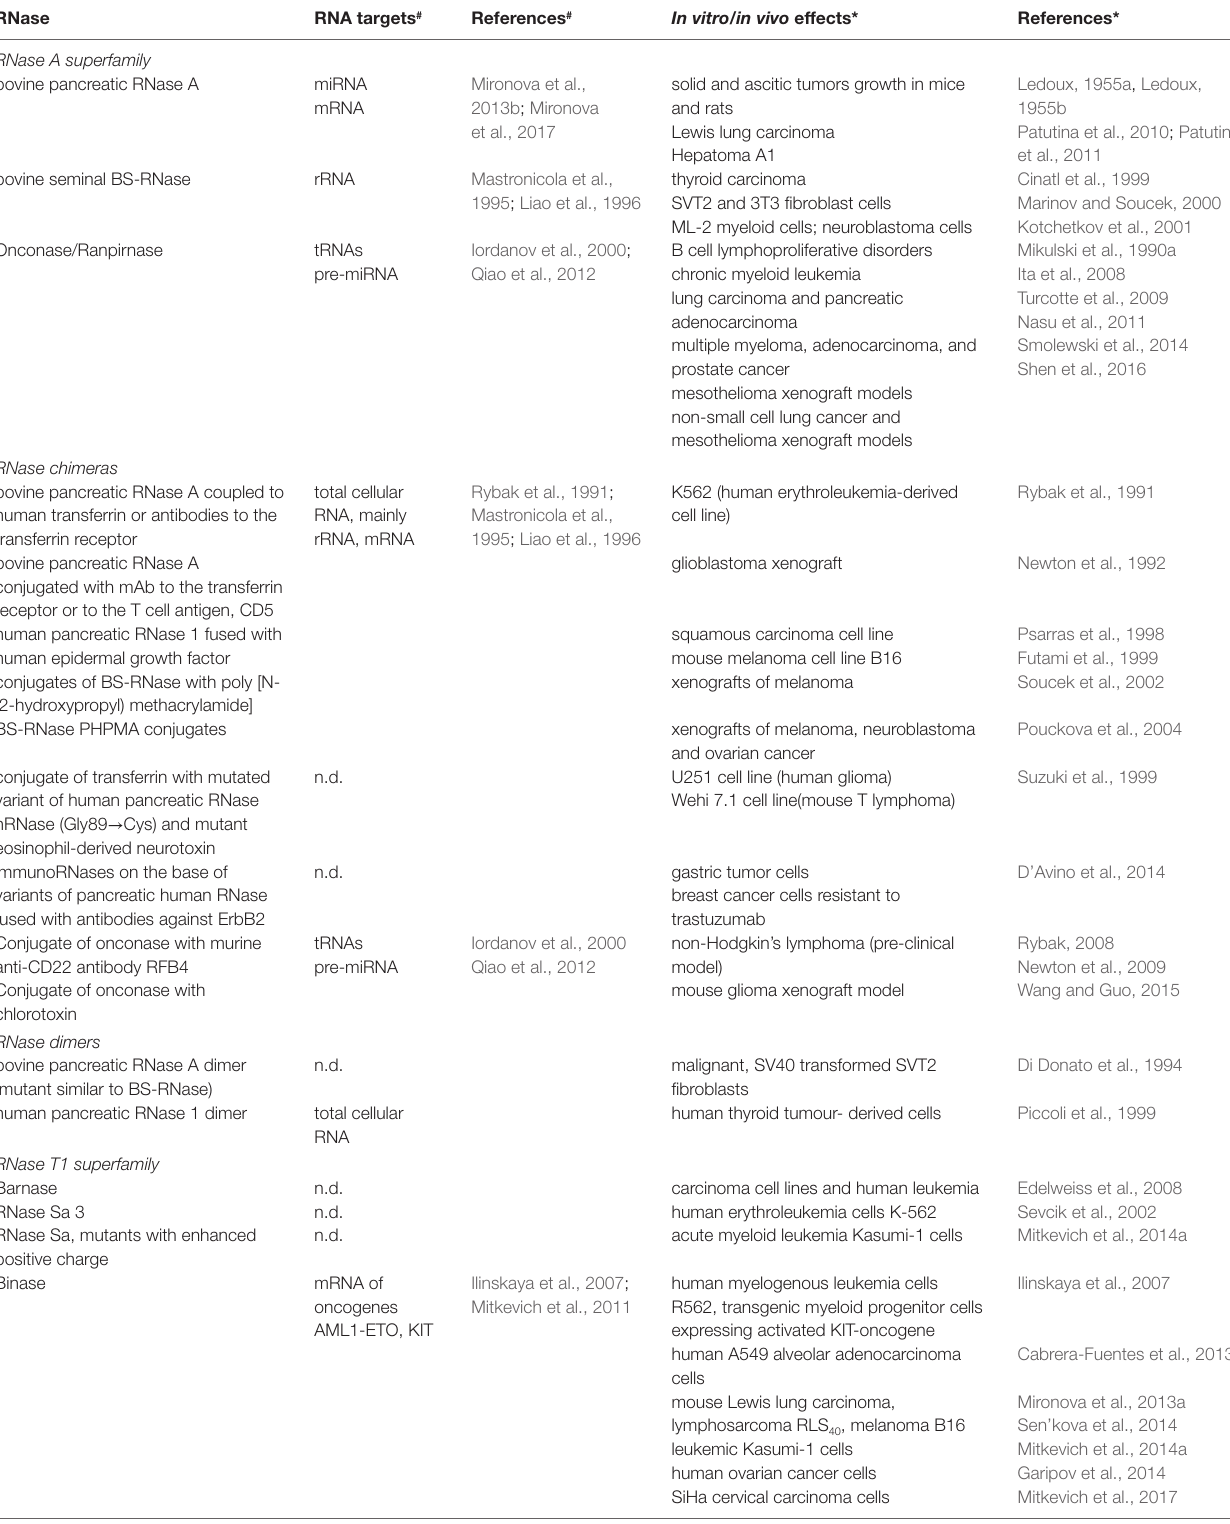
TABLE 4 | Exogenous RNases displaying antitumor